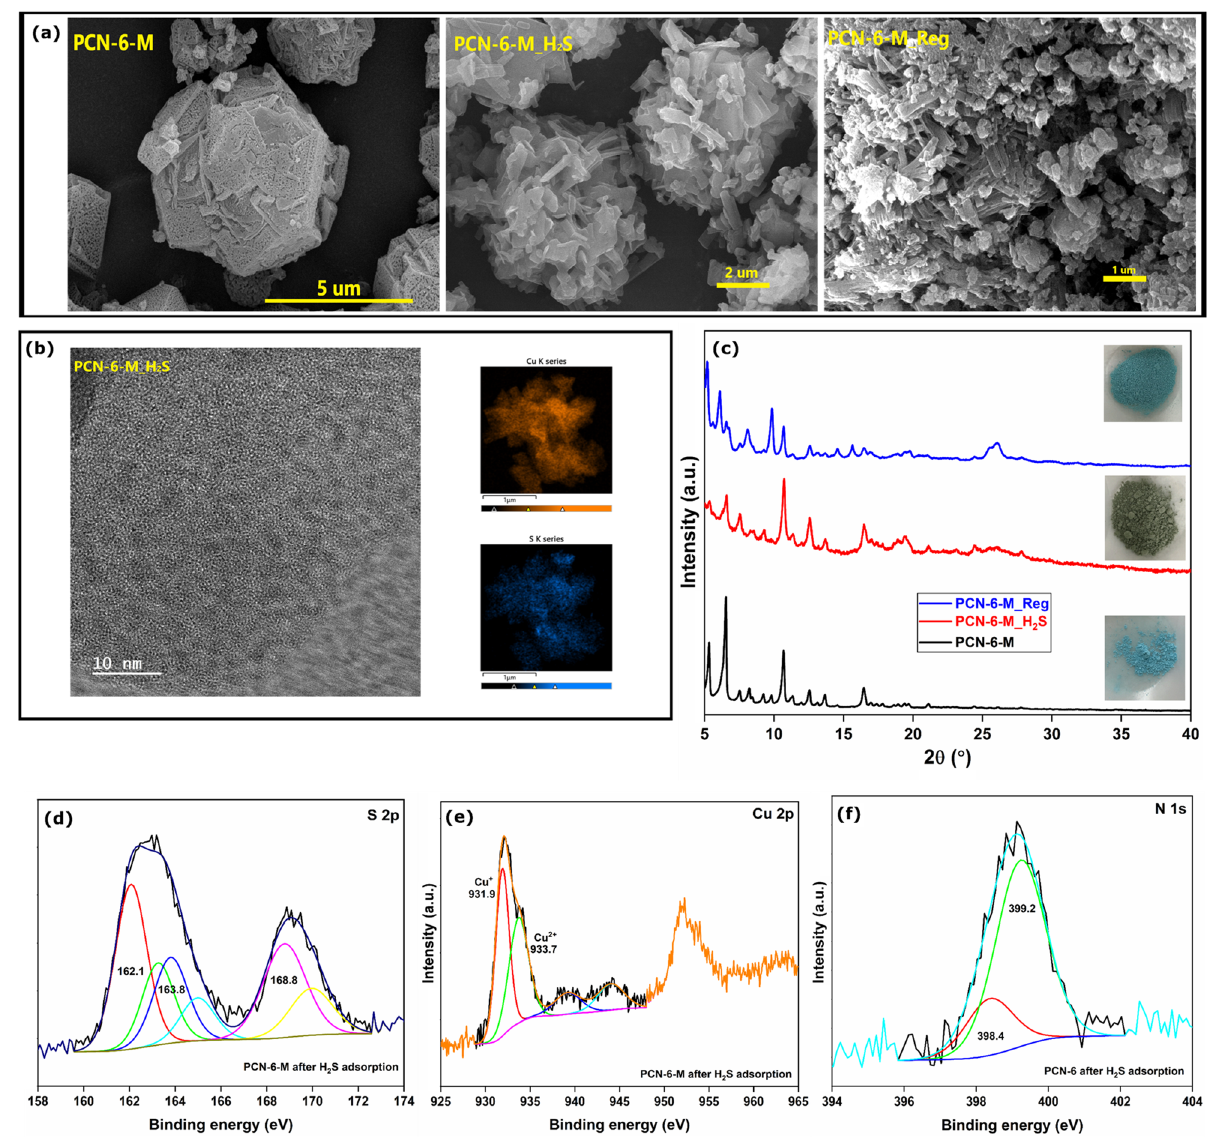
Figure 5. ( a ) SEM micrographs ( b ) High-resolution TEM and TEM-EDAX analysis of PCN-6-M_H 2 S; ( c ) PXRD patterns; ( d ) S 2p; ( e ) Cu 2p; ( f ) N 1s spectra of PCN-6-M after H 2 S